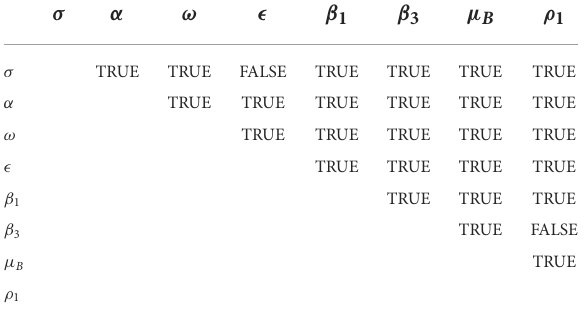
TABLE 6 Parameters different after FDR adjustment.